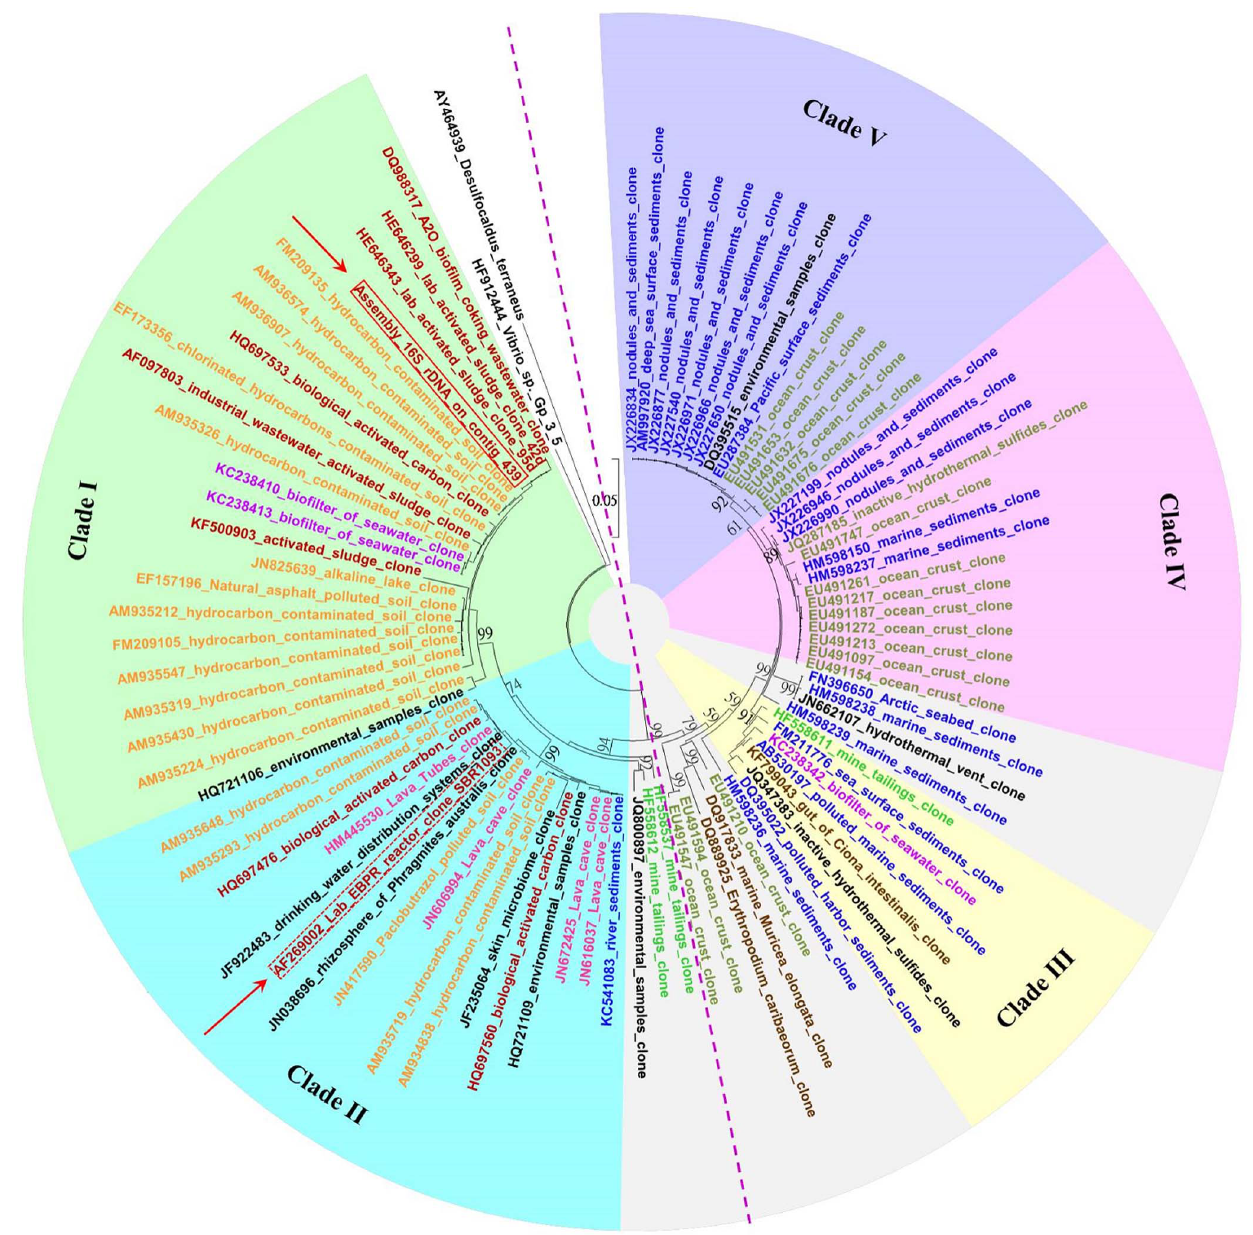
Figure 2. Phylogeny of phylotypes affiliated with the candidate phylum SBR1093. This phylogenetic tree is constructed with 16S rRNA gene sequences based on the neighbor-joining method with Jukes and Cantor distances. The main clades with nodes supported by a bootstrap value of . 50% are labeled and marked with different background colors (Clade I green, Clade II blue, Clade III yellow, Clade IV pink and Clade V purple). The phylotypes derived from different sources are labeled with the following: dark red, activated sludge; orange, soil; blue, sediments; dark green, ocean crust; pink, lava; purple, seawater; green, mine tailings; brown, marine organisms; black, others. The phylotype SRB1093 HKSP obtained in this study is enclosed with a solid red line, whereas the first reported phylotype is enclosed with a red dashed line. The scale bar represents 0.05